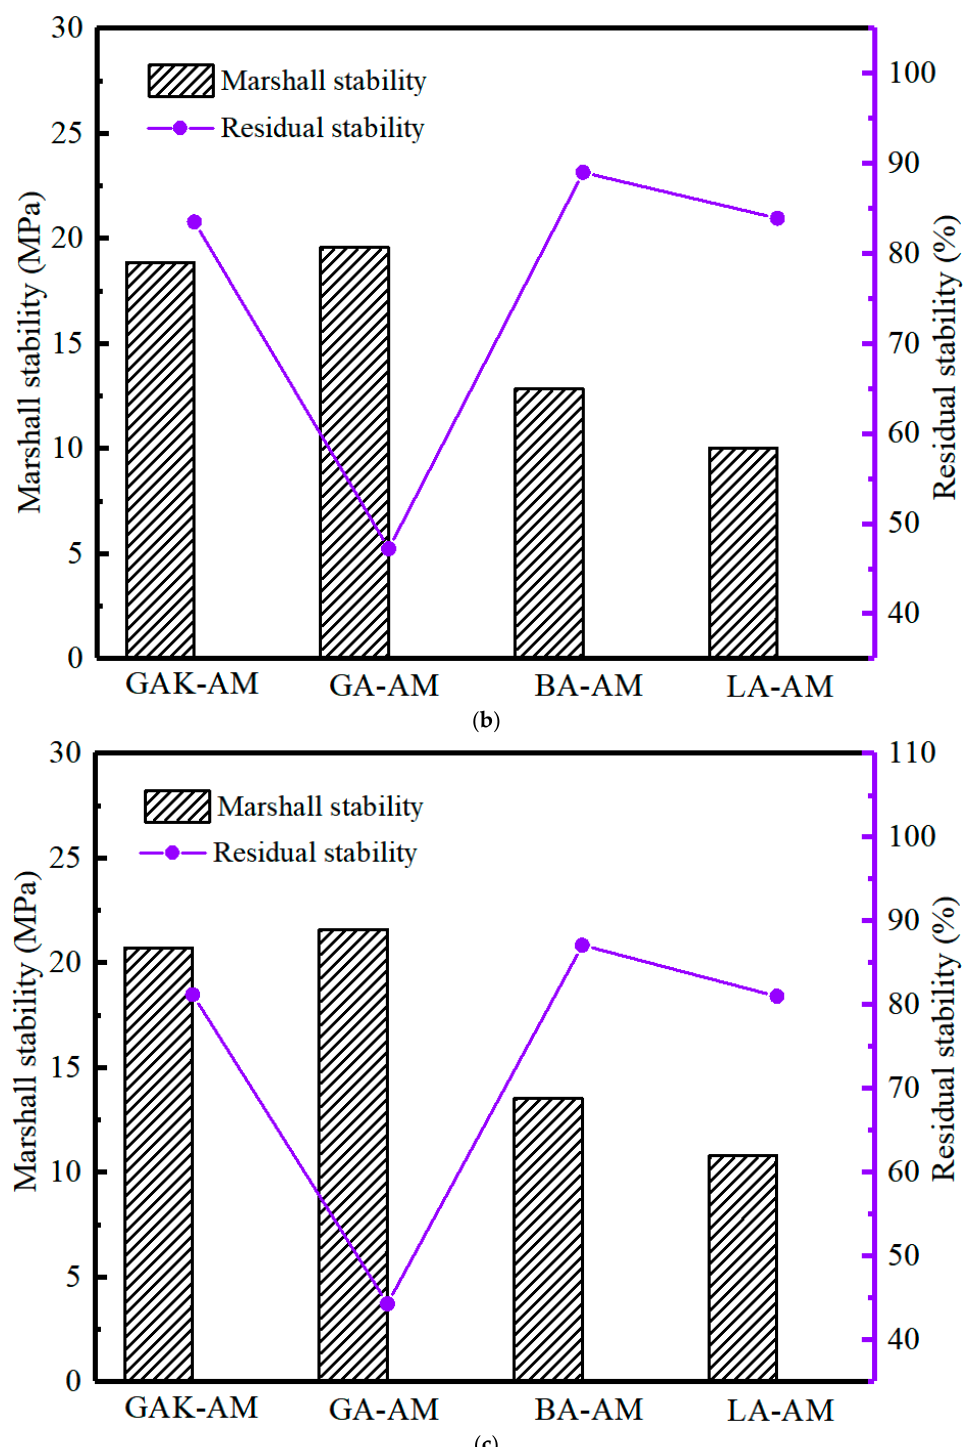
Figure 7. Mixture Marshall test of asphalt mixture ( a ) unaged, ( b ) short-term aged, ( c ) long-term aged. Moreover, under aging conditions, the stability of GAK-AM was higher than that of BA-AM and LA-AM, and its residual stability was greater than 80%, indicating that SCA had significantly improved the aging resistance of the granite aggregate. The test results showed that the SCA improved the adhesion between asphalt and granite and elevated the asphalt mixture’s water damage resistance. Similar results were reported by Yang et al.